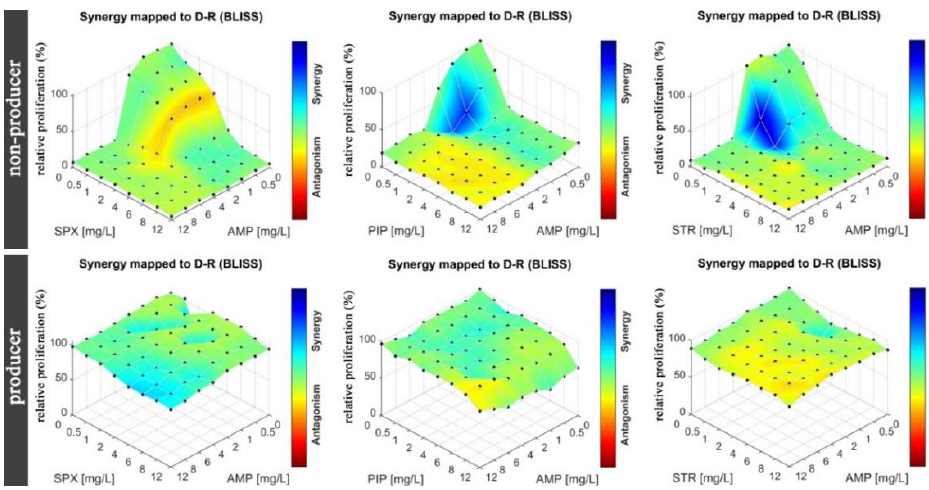
Figure 6. Bacteria proliferation as a function of two drug concentrations, where one of the drugs is ampicillin. Bliss scores overlapped over the proliferation map (color-coding). ( Top ) bacteria that do not produce beta-lactamase. ( Bottom ) Beta-lactamase producing strain. Each row represents results from a single mAST containing 4 experiment repetitions.